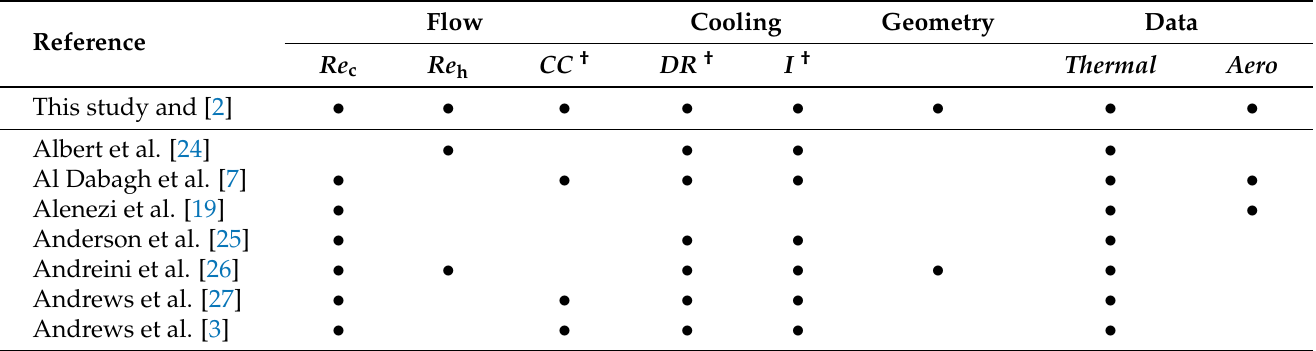
Table A1. Overview of references with similar research. The marked cells indicate whether the individual reference attend to different flow parameters, cooling similarities, the double-wall combustor geometry and thermal or aerodynamic data availability. For this overview, the details of available data are not considered, e.g., most of the aerodynamic data comprise the discharge coefficients and pressure losses with no detailed flow field as presented in this